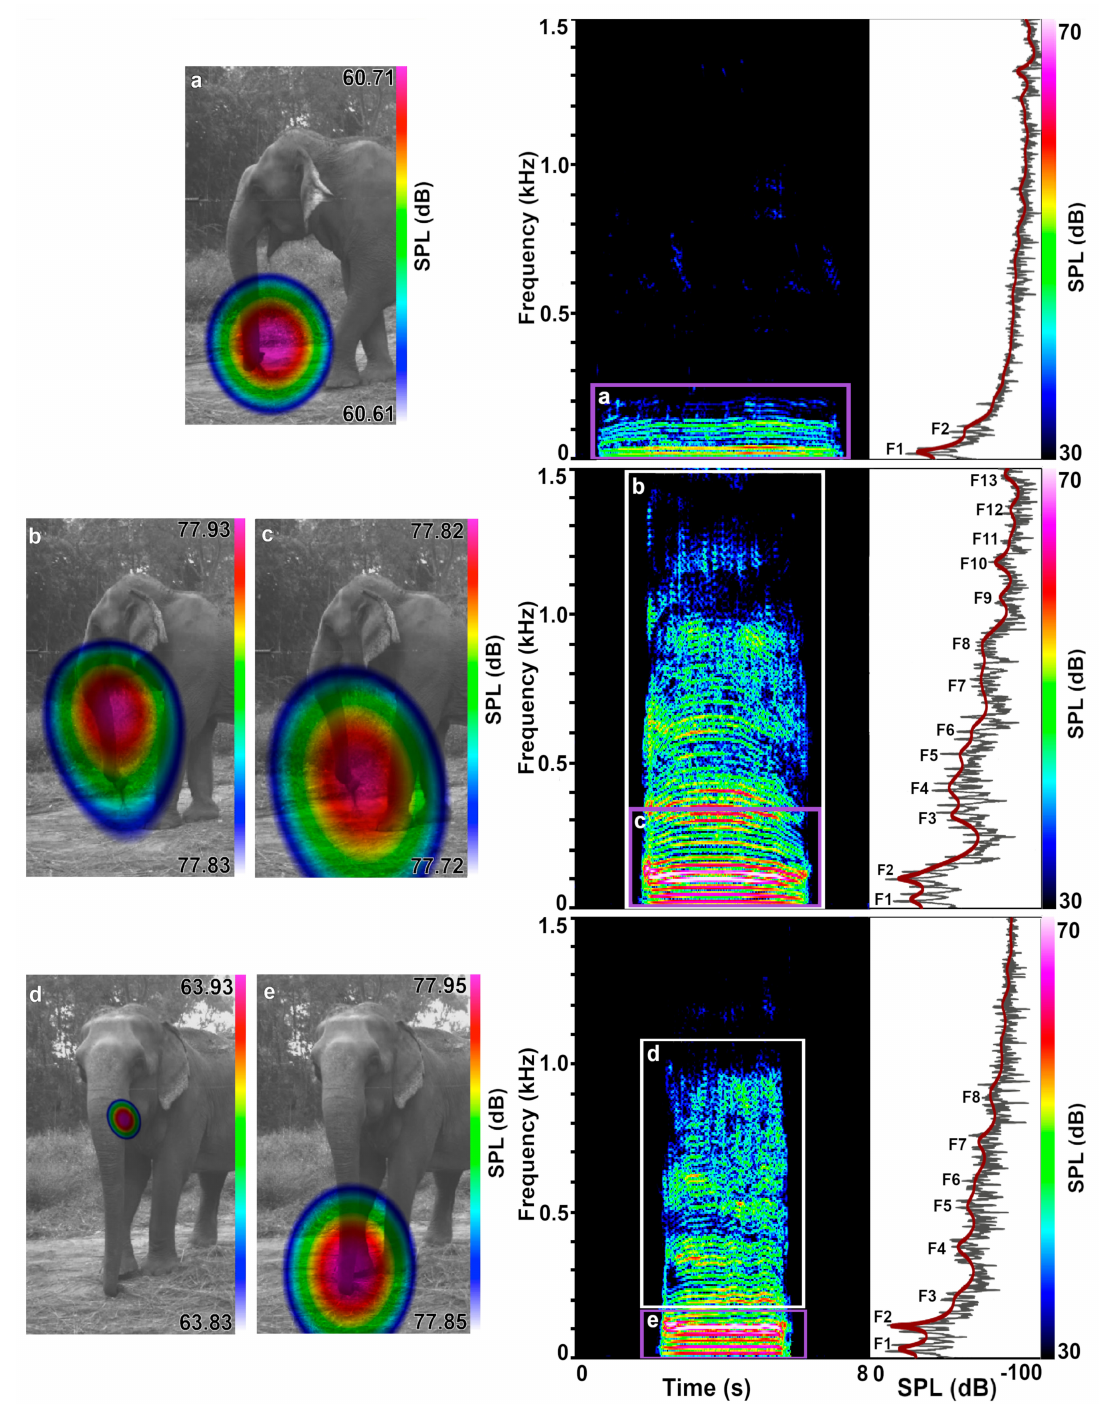
Figure 2. Examples of rumble emission types. Rumbles emitted in succession by Pawan (f, 55y) during the separation phase of the separation–reunion experiment showing the acoustic camera images (left), spectrograms (middle) and power spectra (right). The LPC function lines in red indicate the formant positions (F1–F13). ( a ) Nasal rumble; ( b ) Mixed emission, with oral emission but with a distorted sound sphere appearing when the whole call is selected; ( c ) Nasal part of the mixed rumble when lower harmonics are selected; ( d ) Oral part of a mixed rumble when only upper harmonics are selected; with ( e ) a more dominant nasal part when only the lower harmonics are selected. Note that during ( a ) nasal rumble emission the elephant was chewing and the mouth at times wide open as defined by jaw